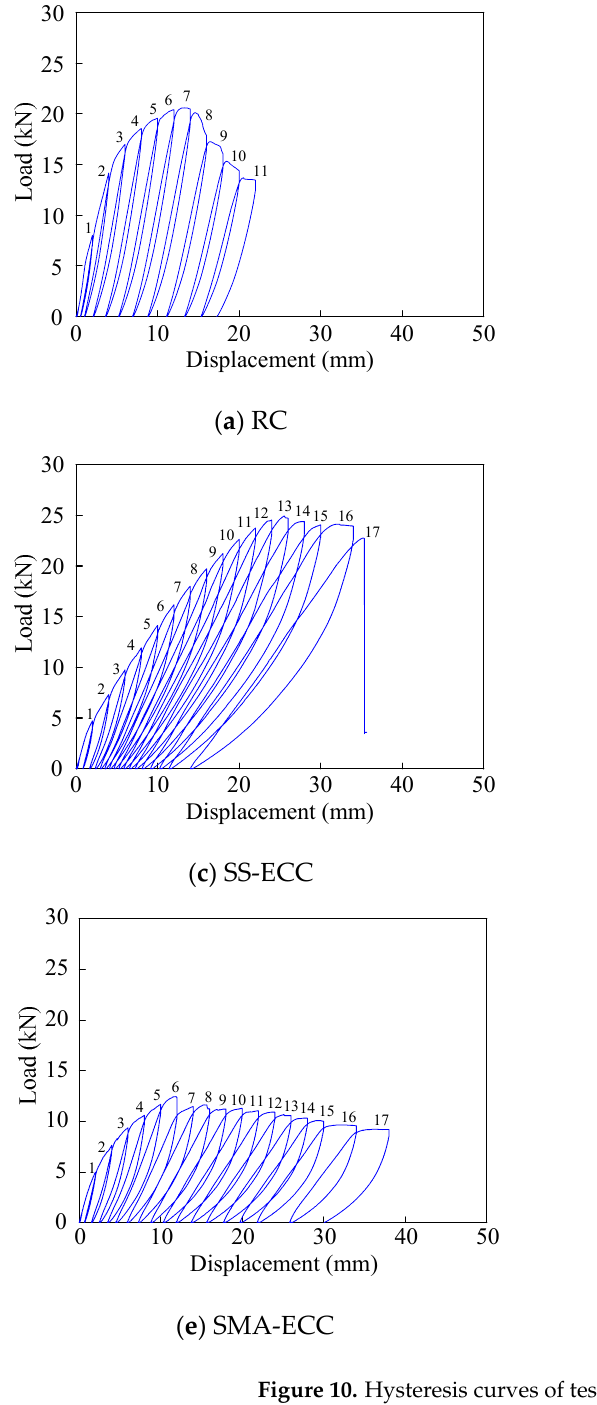
Figure 14, including the values corresponding to both loading and unloading peak points.